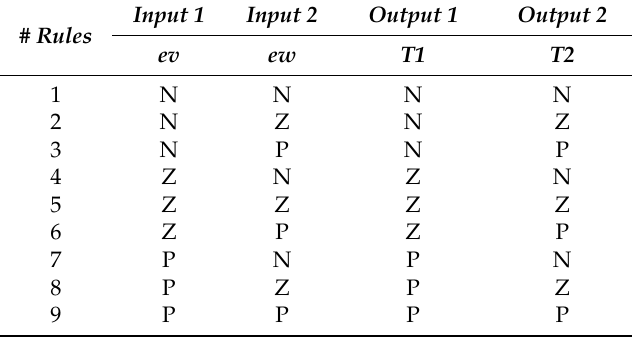
Table 1. Fuzzy Rules used by the Fuzzy